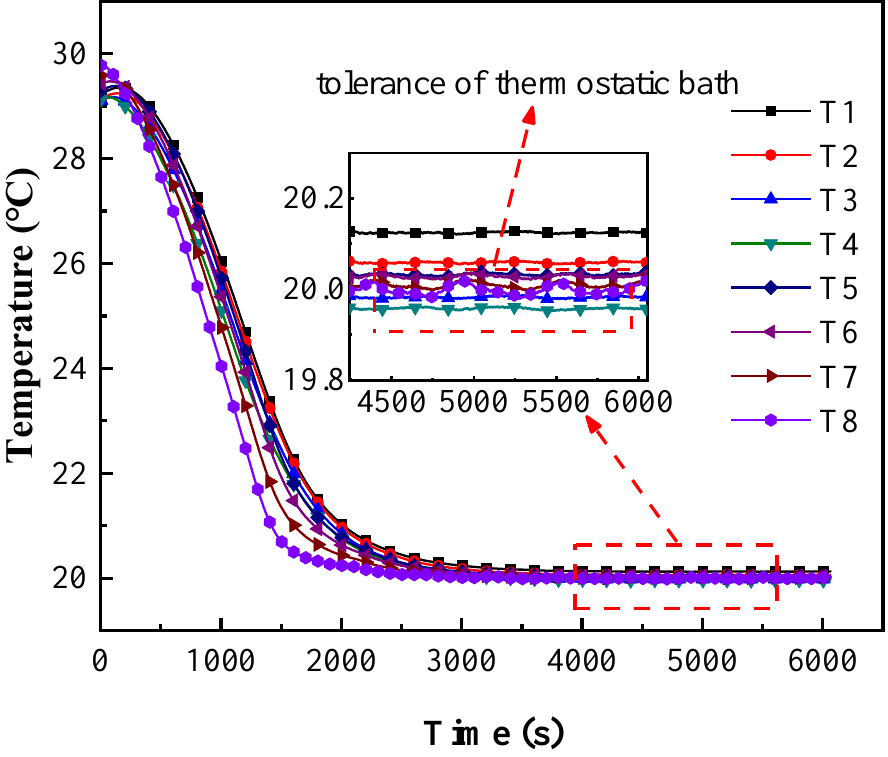
Figure 4. Pre-calibration of the platinum resistance thermometers at 20 °C . During the experiment, the heat flow from the upper copper container reached the lower copper container through fluxmeters and samples. Since the temperatures of the cold and heat sources were constant, the system quickly reached a steady state within 60 mins and then was maintained for 30 mins to obtain the averaged temperatures of T1–T8, which were obtained by connecting platinum resistance thermometers with a data acquisition